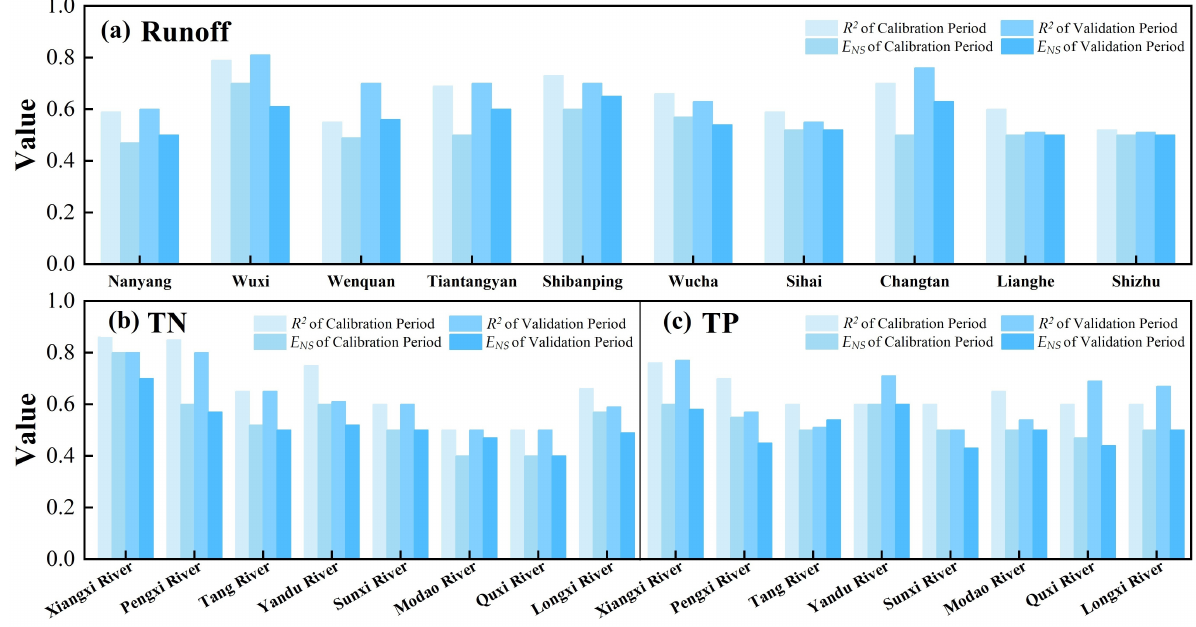
Figure 2. The calibration and validation results of runoff ( a ), TN ( b ), and TP ( c ) loads. It was expected that a slightly weaker performance for the water quality simulation would be observed compared to that for runoff. The main reason for this was that the than those that the runoff and the changes in hydrodynamic conditions and underlying surface characteristics would affect the simulation of the complex pollutant transport